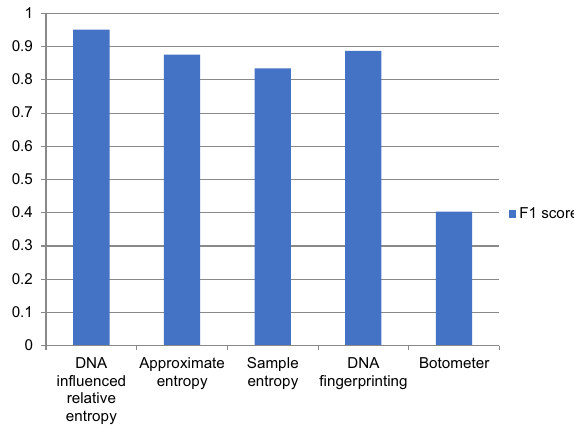
Figure 7. Comparison of F1 score metric for different state-of-art approaches.